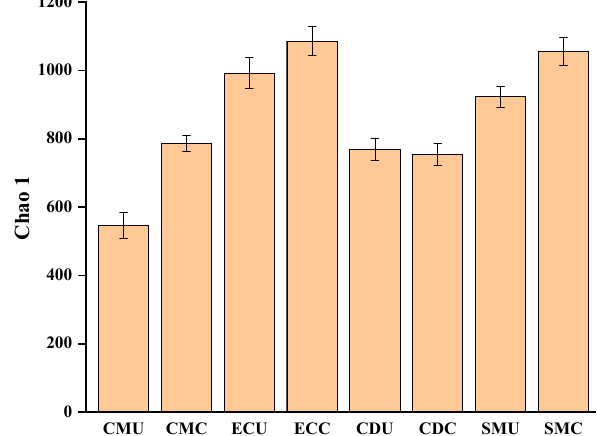
Figure 1. Richness of bacterial communities in organic fertilizers using the Chao1 estimator. Samples from compost were denoted CDC, CMC, SMC, and ECC. Uncomposted manure samples were denoted CDU, CMU, SMU, and ECU.